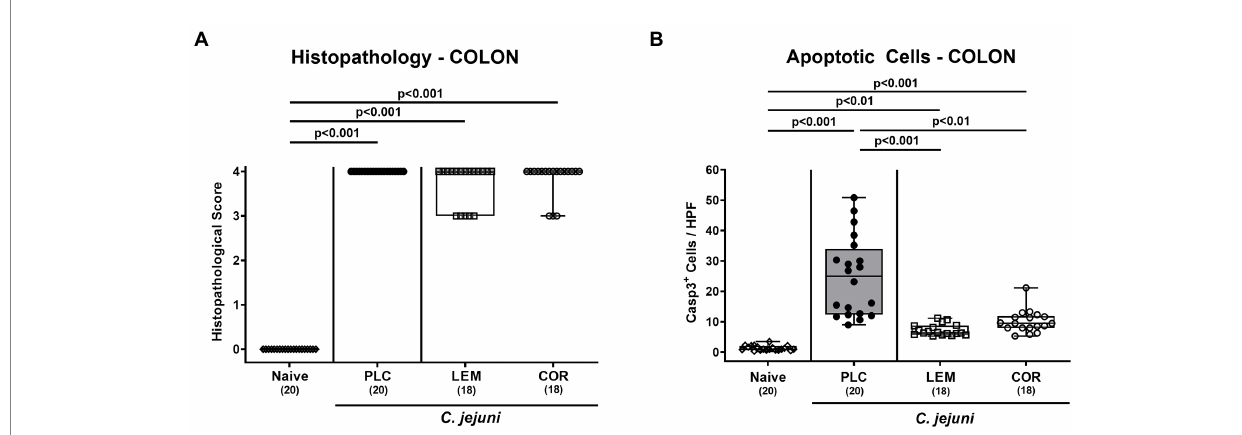
FIGURE 3 Microscopic inflammatory changes in the colon following prophylactic oral application of lemon or coriander essential oil to C. jejuni infected mice. SAB IL-10 − / − mice were subjected to prophylactic lemon (LEM; white squares) or coriander (COR; white circles) essential oil via the drinking water ( ad libitum ) starting 7 days prior infection. Placebo (PLC; black circles) control animals received tap water only. On days 0 and 1, mice were then perorally infected with C. jejuni strain 81–176 by gavage. (A) Colonic histopathological changes were surveyed on day 6 post-infection in hematoxylin and